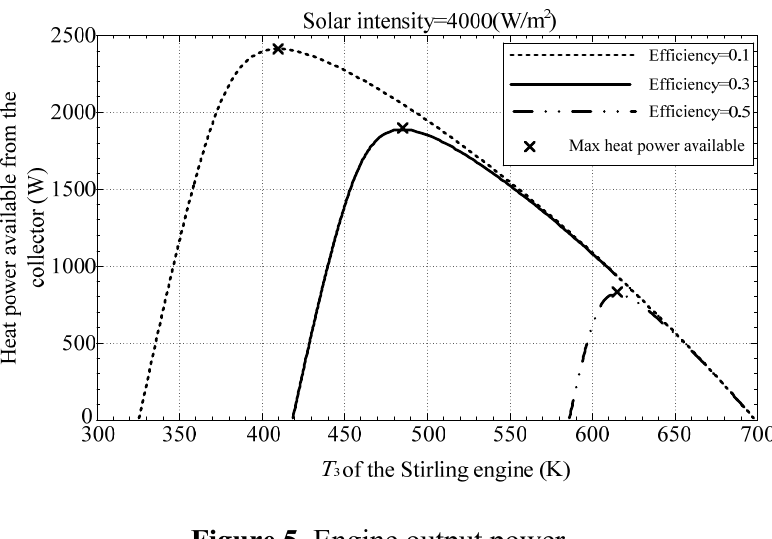
Figure 4. Available power from the collector.